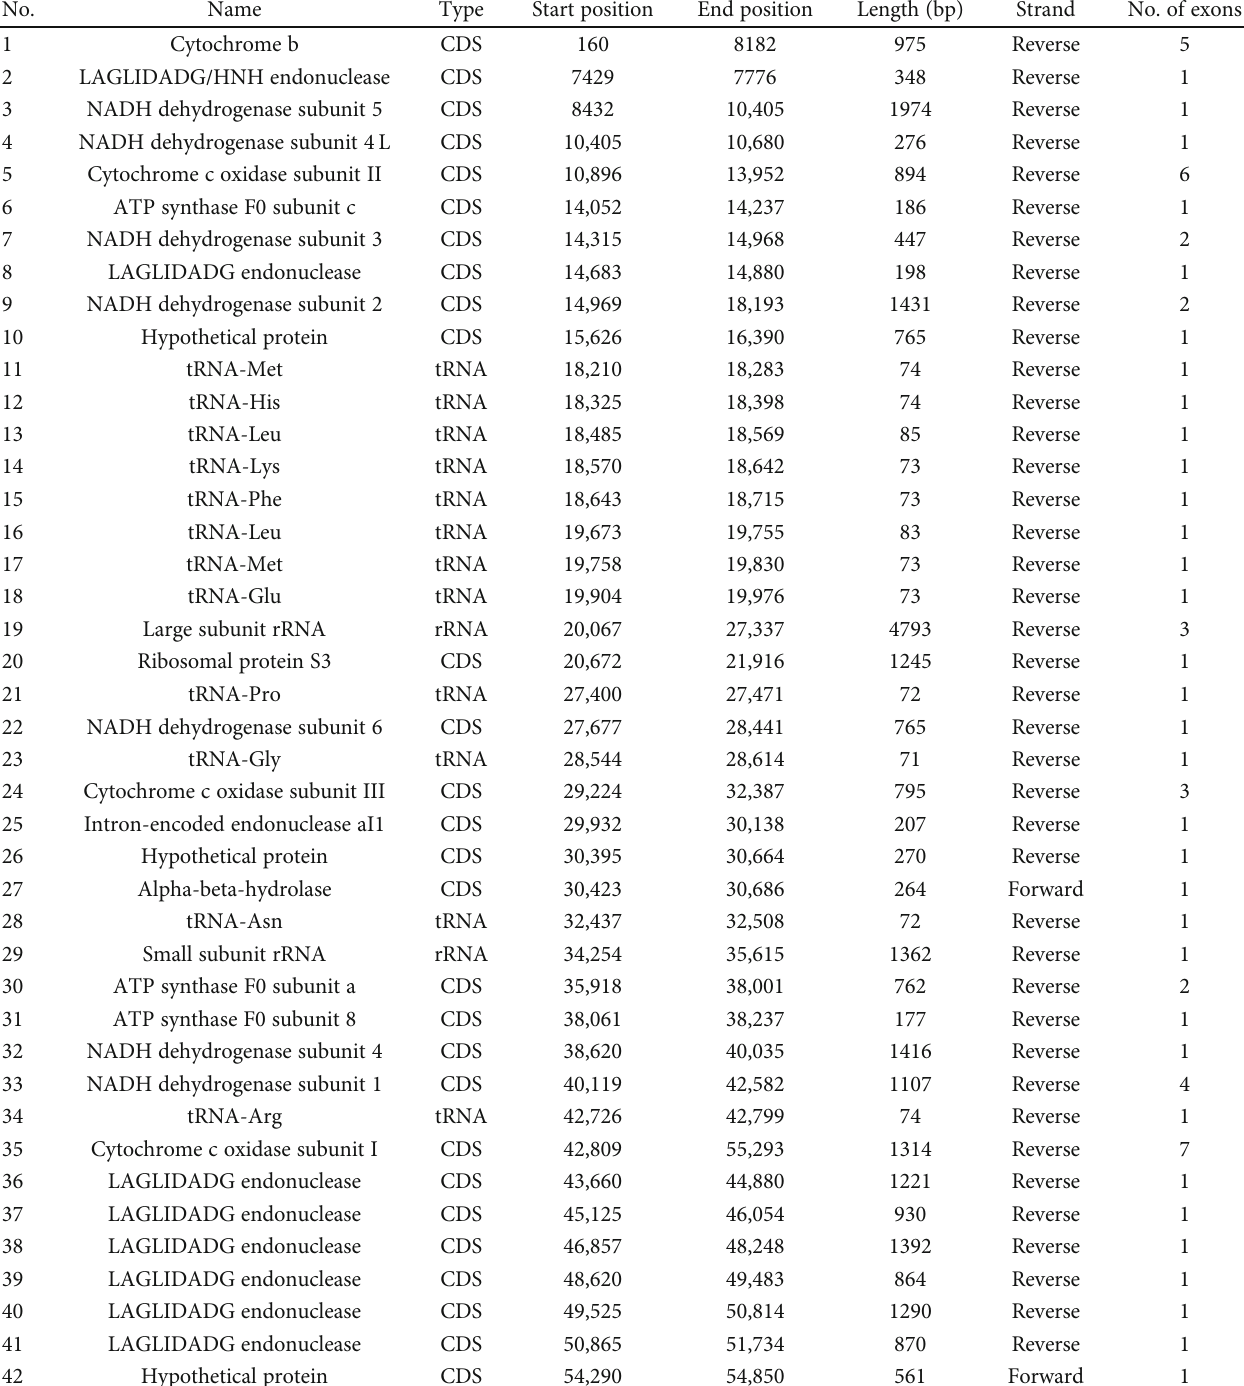
Table 2: List of genes in WBPH fungal endosymbiont